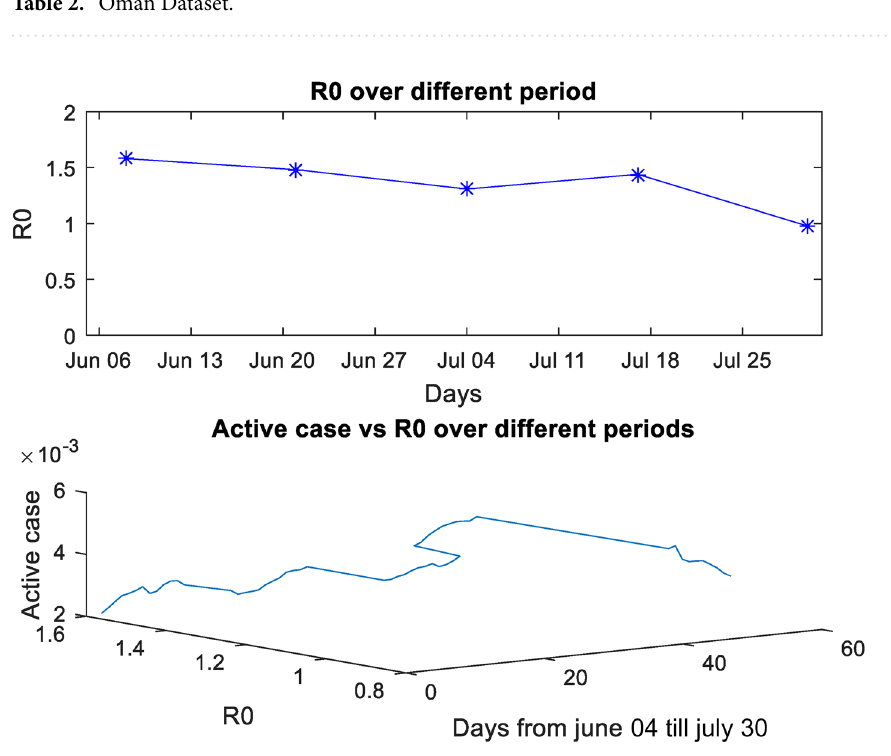
Figure 4. R 0 and active case versus time.